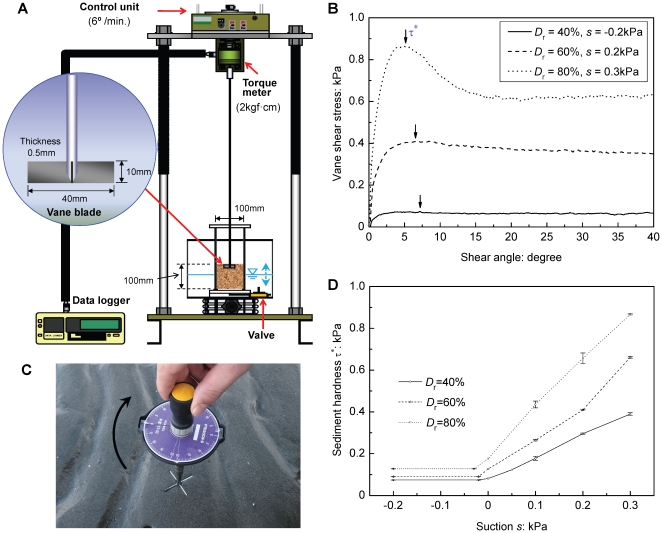
Sediment hardness as assessed by the vane shear strength.(A) High-resolution vane shear testing system in the laboratory. Sediments with prescribed sediment relative densities D
r were formed in an acrylic cylindrical chamber set in a larger water tank. Suctions s at the level of the sediment surface were varied by changing the water level in the tank. The vane shear testing was performed by inserting and rotating the vane blade in the uppermost layer of the given sediment. (B) Results of the vane shear testing. The peak value of the measured vane shear stresses represents the vane shear strength τ*, namely the sediment hardness. (C) Field vane shear testing apparatus for surficial sediments. The apparatus directly measures τ*. (D) Sediment hardnesses simulated in the laboratory as functions of suctions and sediment relative densities of the intertidal sediments taken at the Nojima tidal flat. Data in (D) were obtained using both apparatuses shown in (A) and (C) and represent mean values ± SE.